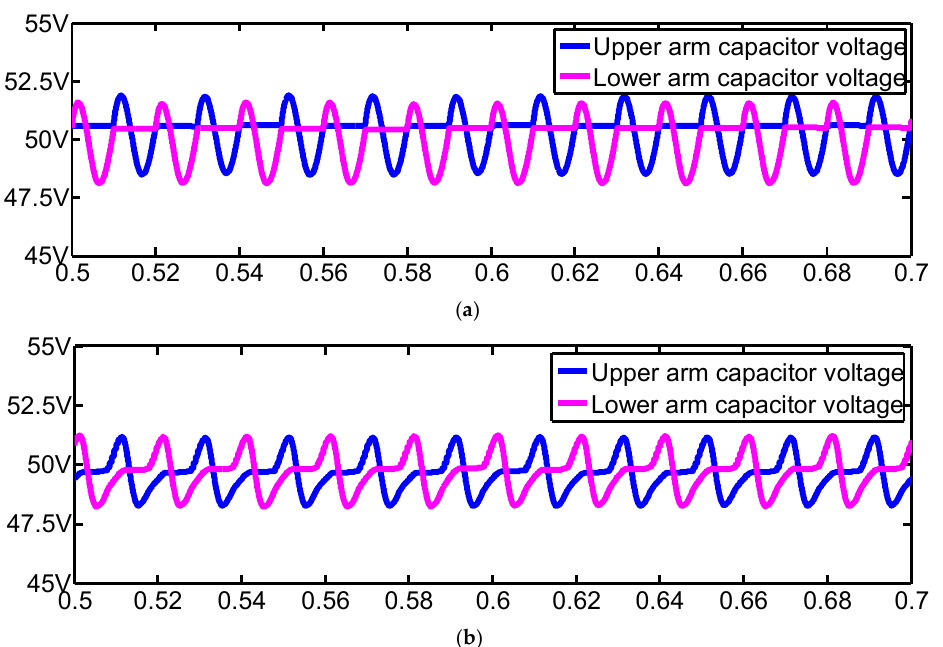
Figure 20. HBSM capacitor voltages of the proposed hybrid MMC under different λ : ( a ) λ = 1; ( b ) λ = 0.5.